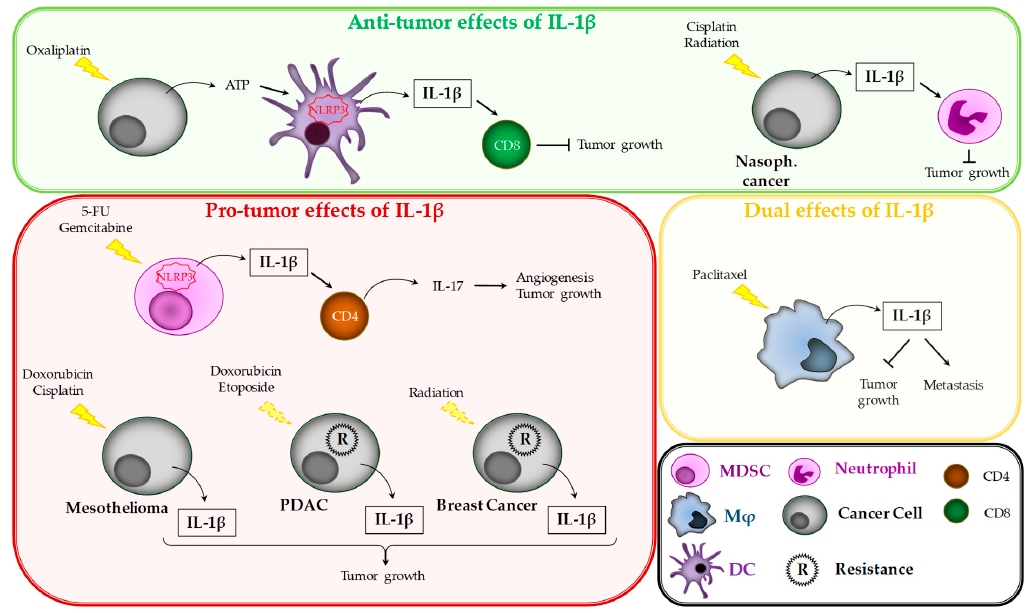
Figure 3. Involvement of IL-1 β in chemotherapy-mediated effects on immune cells. PDAC, pancreatic ductal adenocarcinoma.